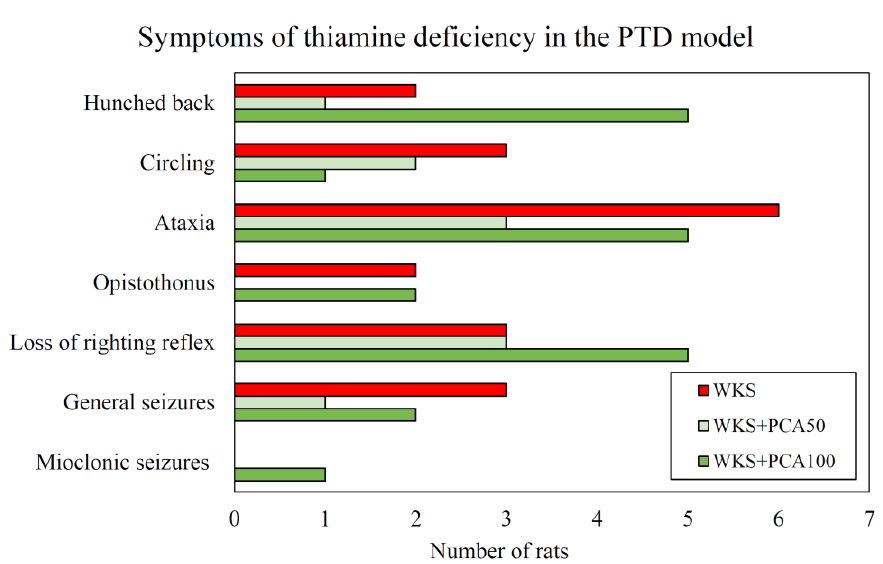
Figure 2. The frequency of neurological symptoms recorded in animals during the period of pyrithi- amine administration. The control group (no pyrithiamine and, hence, no PTD symptoms) is not visualised.